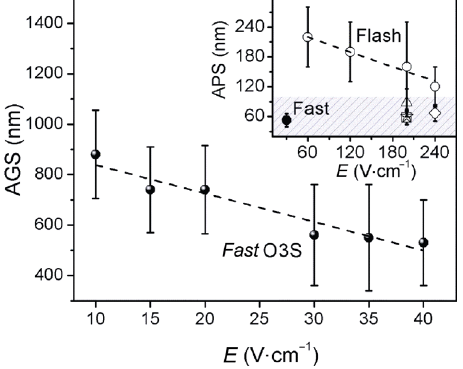
Fig. 7 Average grain size (AGS) after fast O3S processing of CCTO with the current density limit of J = 42.0 mA·m − 2 . Inset: average particle size (APS) applying for fast CCTO synthesis (closed circle; specimen at point (c) in Fig. 2(a)), and flash CCTO synthesis for different fields with the current density limit of J = 22.0 mA·mm − 2 (open circles); for E = 200 V·cm − 1 with J = 10.0 mA·mm − 2 (open triangle), J = 7.5 mA·mm − 2 (open star), and J = 5.0 mA·mm − 2 (open square; specimen at point (g), Fig. 2(a)); and finally for E = 240 V·cm − 1 with J = 12 mA·mm − 2 (open diamond). The dashed lines are just a guide for